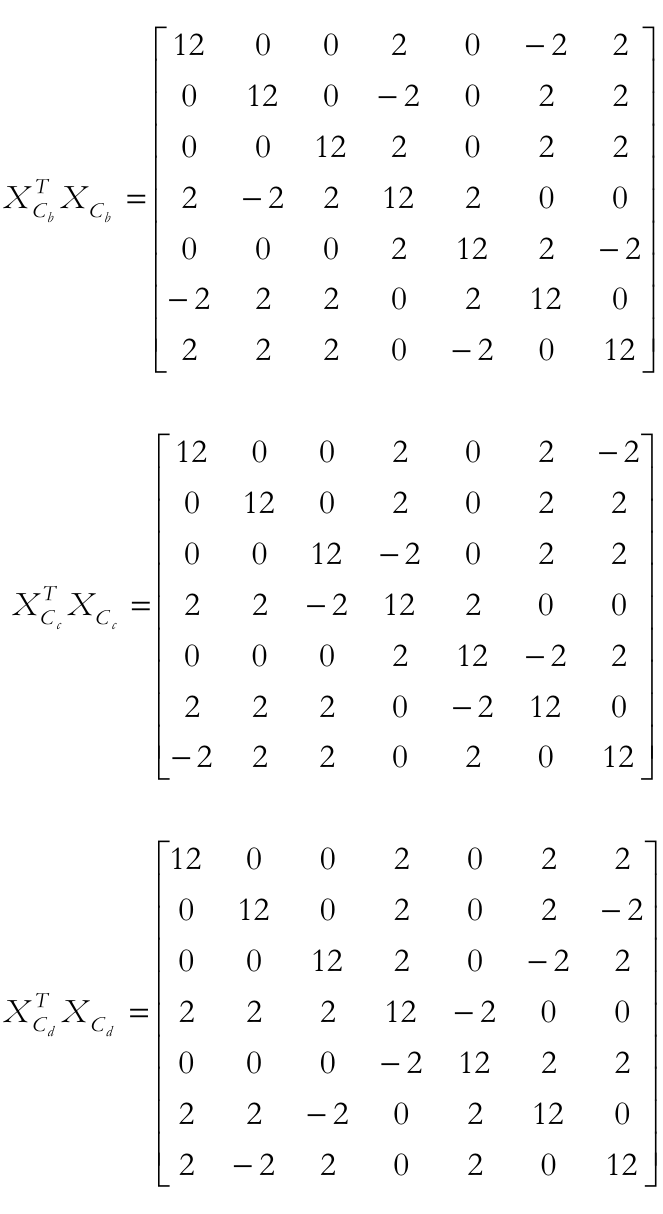
, C , D , C , C , C , a b c d e f